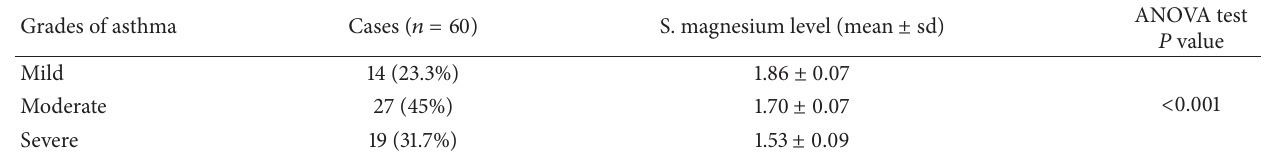
Table 4: Serum magnesium levels in asthma.